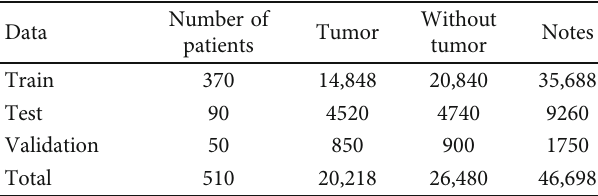
Table 3: Some distinct sorts of CT scan slices in the